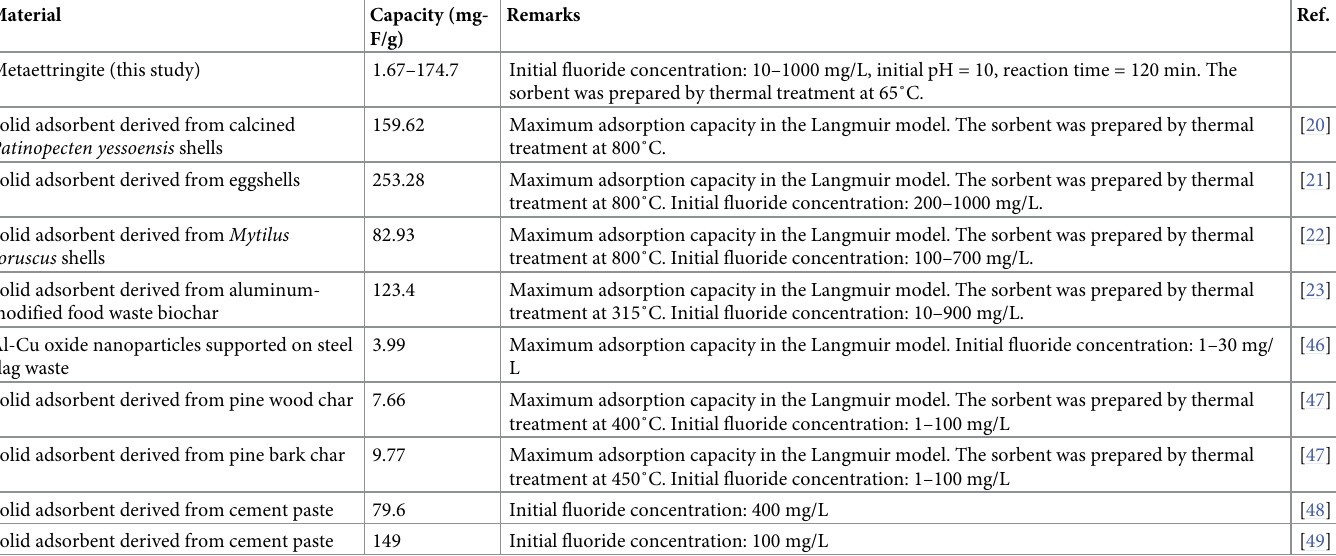
Table 4. Comparison of the fluoride removal capacities of metaettringite and other solid materials prepared from by-products or waste.